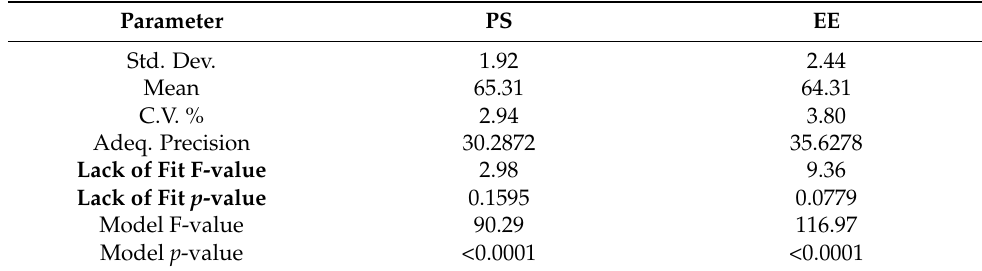
Table 5. Model (quadratic) fit summary of the